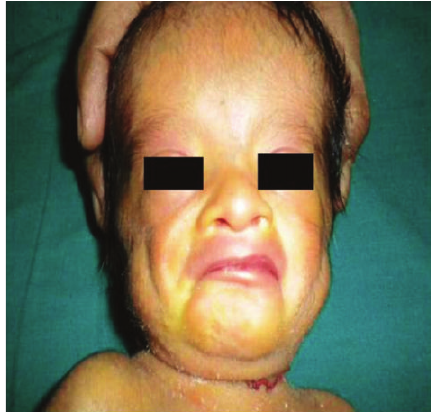
Figure 3: The patient’s karyotype shows an extra supernumerary chromosome.